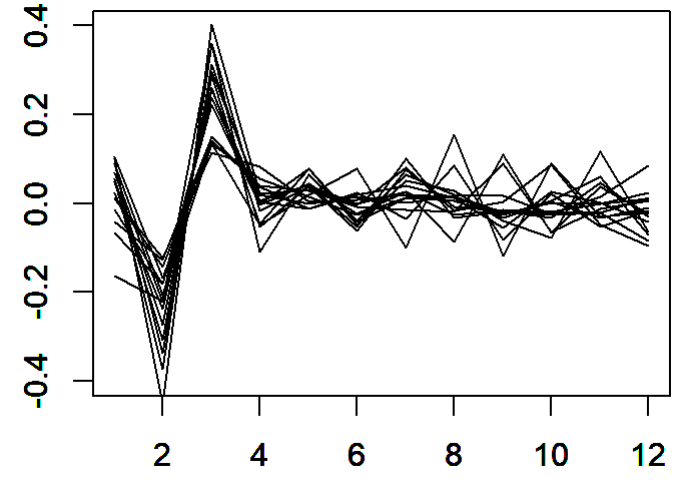
Figure 4. The yearly differentiated log container throughput of Shanghai